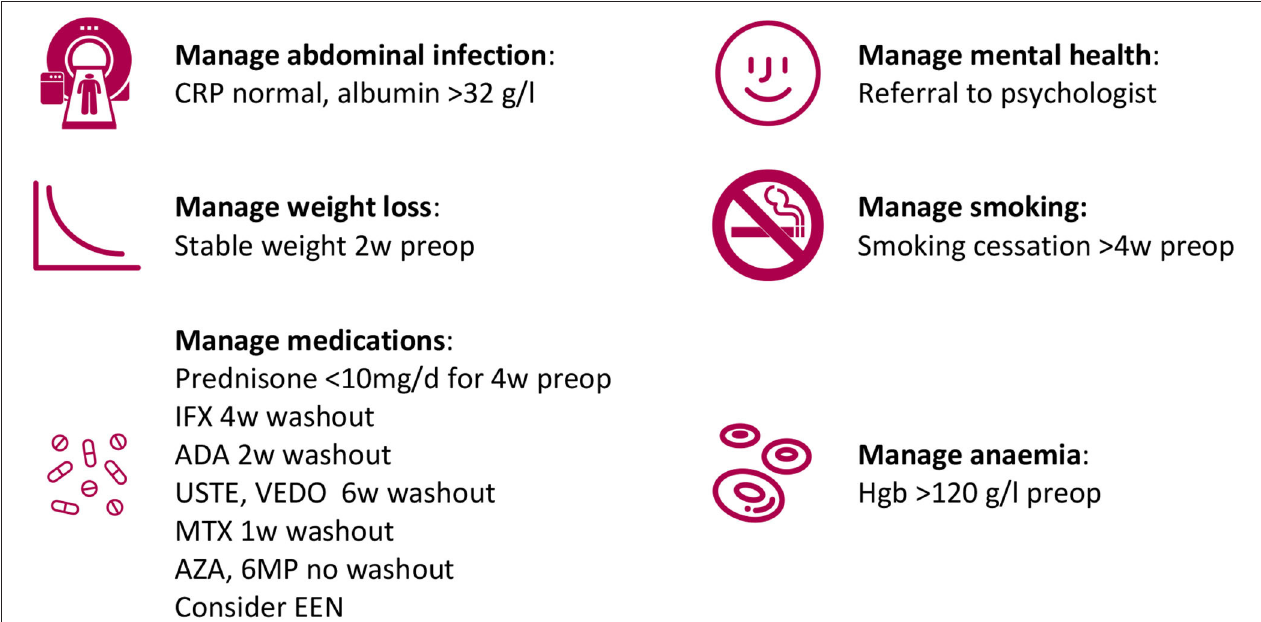
FIGURE 2 | Example of pre-operative optimization